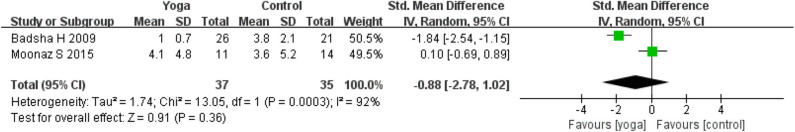
Meta-analysis on Swollen joints count.